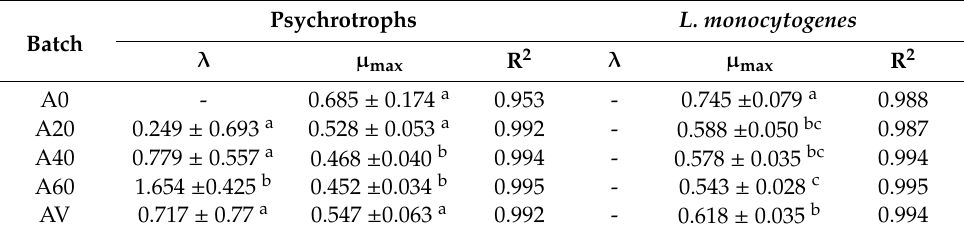
Figure 1. Changes in psychrotroph counts in packaged legs. Packaging conditions: Batch A0, air ( □ ); Batch A20, 80% N 2 /20% CO 2 ( ▪ ); Batch A40, 60% N 2 /40% CO 2 ( • ); Batch A60, 40% N 2 /60% CO 2 ( ◦ ); Batch AV, vacuum ( (cid:78) ). Data shown are each the mean value of six determinations. Table 2. Growth parameters of psychrotrophs and L. monocytogenes in packaged chicken.